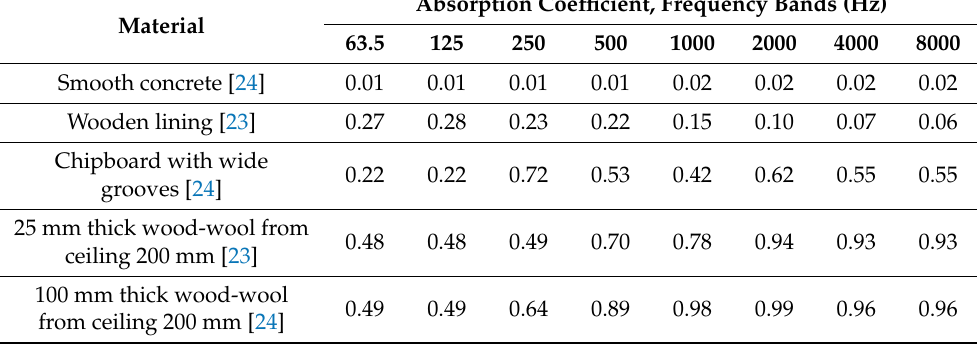
Table 4. Material setting of